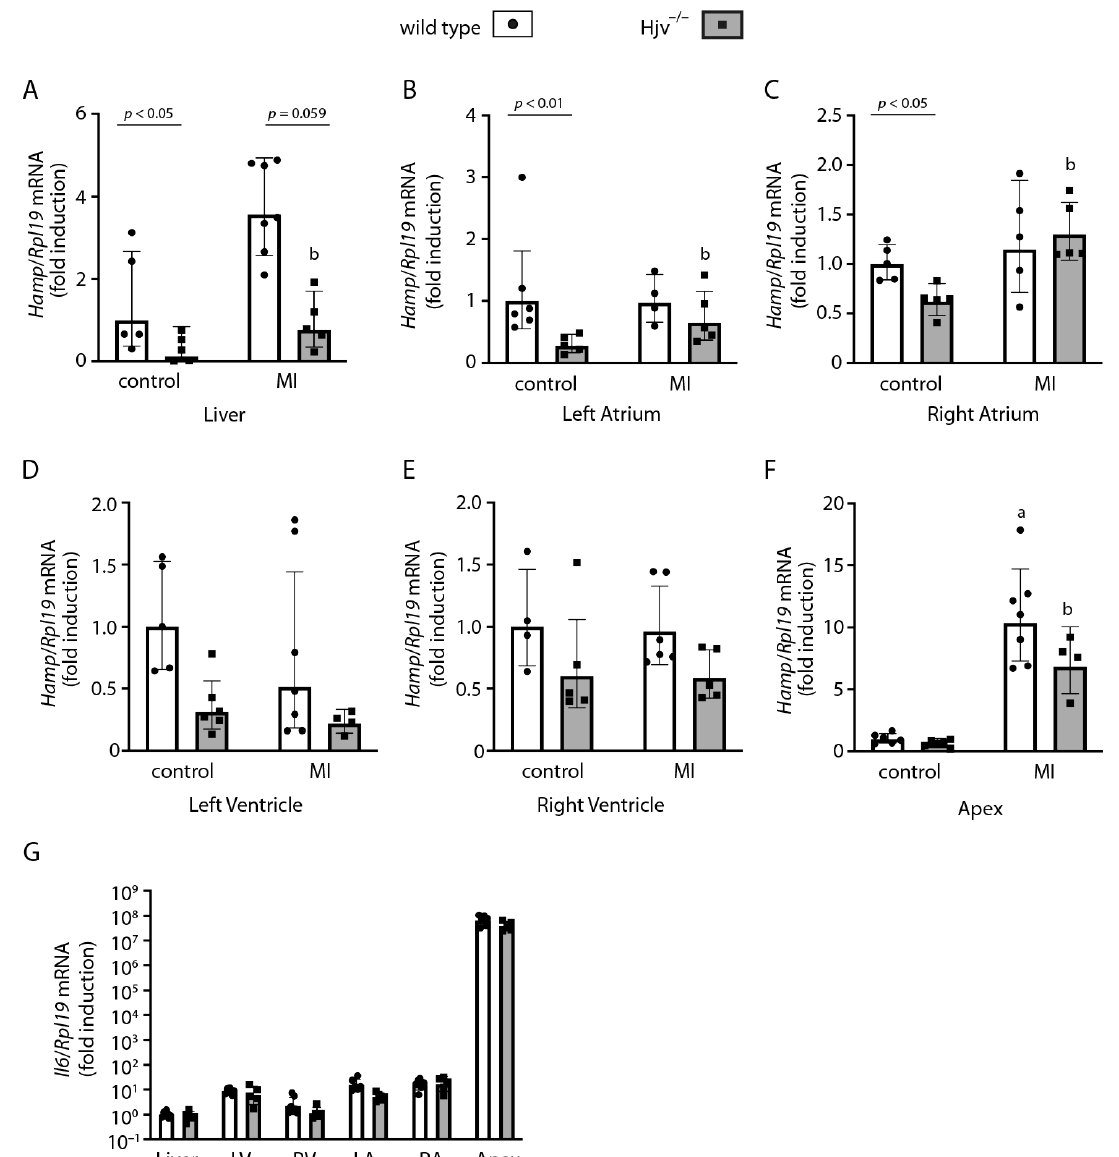
Figure 6 . Myocardial infarction promotes delayed Hamp induction in the liver and the apex of the heart, possibly in response to an inflammatory response in the apex. Mice described in Figure 5 were sacrificed 2 weeks following myocardial infarction surgery. Livers were harvested, and hearts were dissected into chambers. The tissue samples were used for qPCR analysis. Hamp mRNA was quan- tified in: ( A ) liver; ( B ) left atrium; ( C ) right atrium; ( D ) left ventricle; ( E ) right ventricle; and ( F ) apex. Il6 mRNA was also quantified in these tissues ( G ). Data are represented as geometric mean ± geo- metric standard deviation. Statistically significant differences ( p < 0.05) versus values from control wild-type and Hjv − / − mice (not subjected to surgery) are indicated by a and b , respectively.